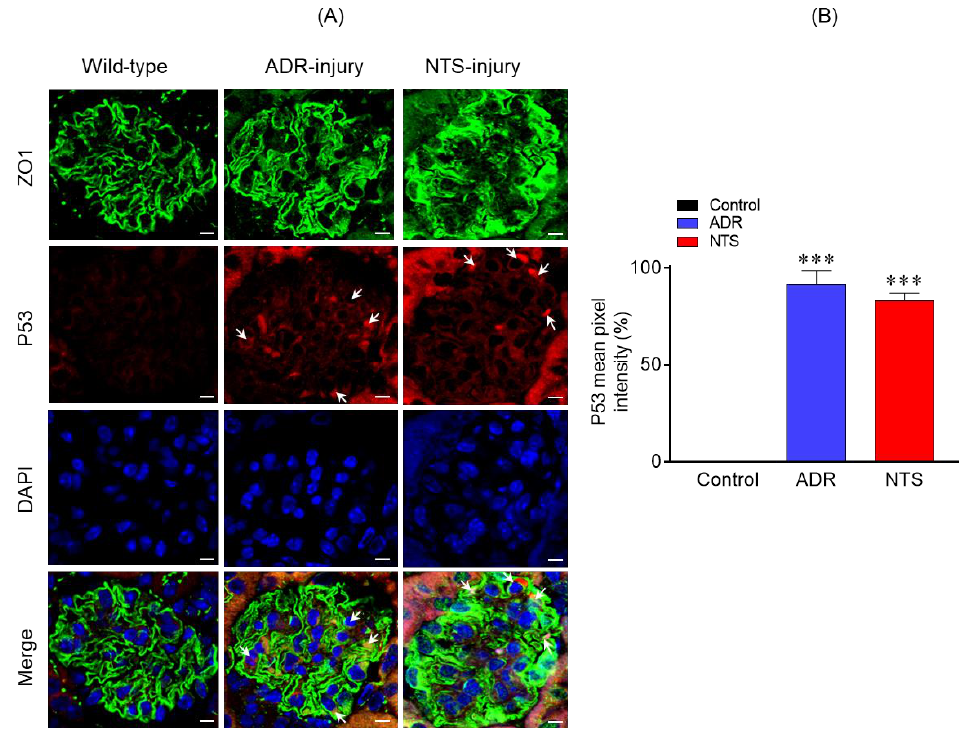
Figure 4. ( A ) Immunostaining analysis of kidney sections using P53 (red) and Zonula Occludens 1 (ZO1) (green) antibodies and DAPI (blue) showed increased P53 staining in the ADR- and nephrotoxic serum (NTS)-injured mice. Scale bar = 10 µm. ( B ) Quantitative analysis of mean pixel intensity showed increased P53 expression in the glomeruli of ADR- and NTS-injured mice compared to the control. A total of 30–40 glomeruli from three mice representing each group were used for statistical analyses. Data are presented as mean ± SEM; two-tailed t -test; *** p ≤ 0.001 ADR vs. control and NTS vs. control.